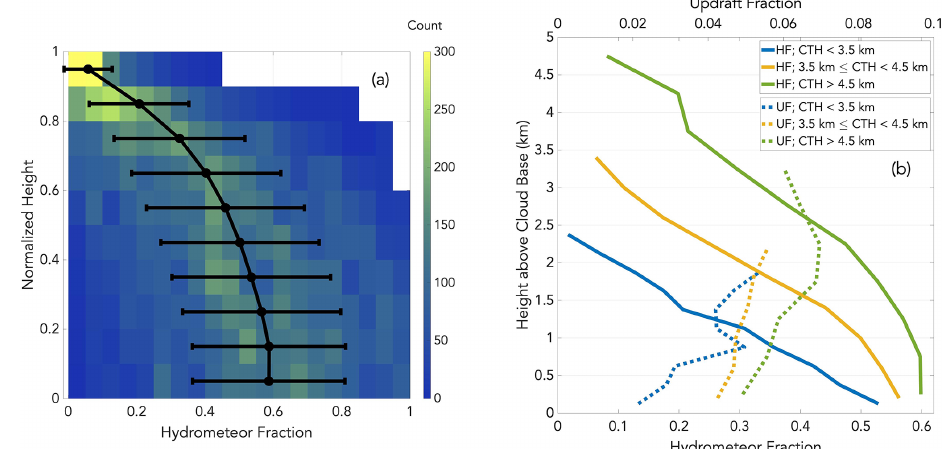
Figure 8. For all 13 COMBLE cases, (a) a joint PDF of hydrometeor fraction (HF) versus normalized height, along with a mean profile of HF as a function of normalized height and (b) mean profiles of HF (black) and updraft fraction (UF; blue) as a function of height above cloud base, with solid lines for cloud tops less than 3.5km, dashed lines for cloud tops between 3.5 and 4.5km, and dotted lines for cloud tops above 4.5km. Prepared using Crameri